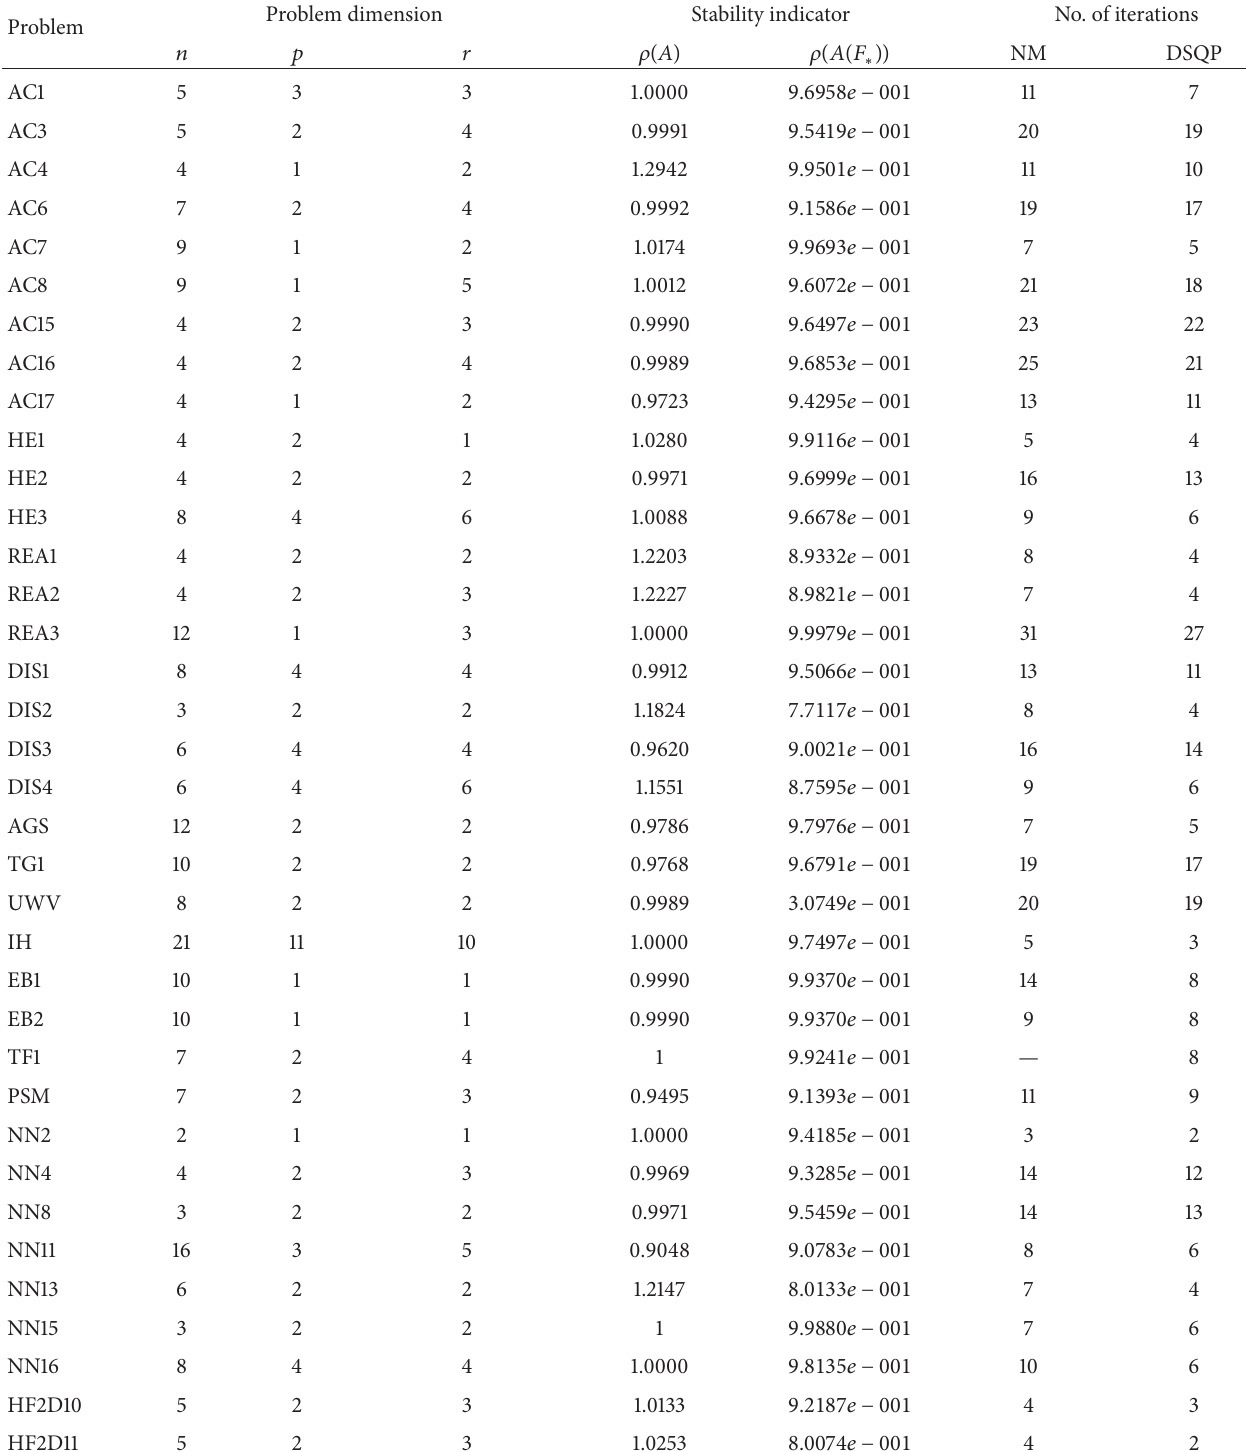
Table 5: Comparison between the methods NM and DSQP for finding the local solutions of the problems (5)-(6) and (10)–(12), respectively; test problems are from